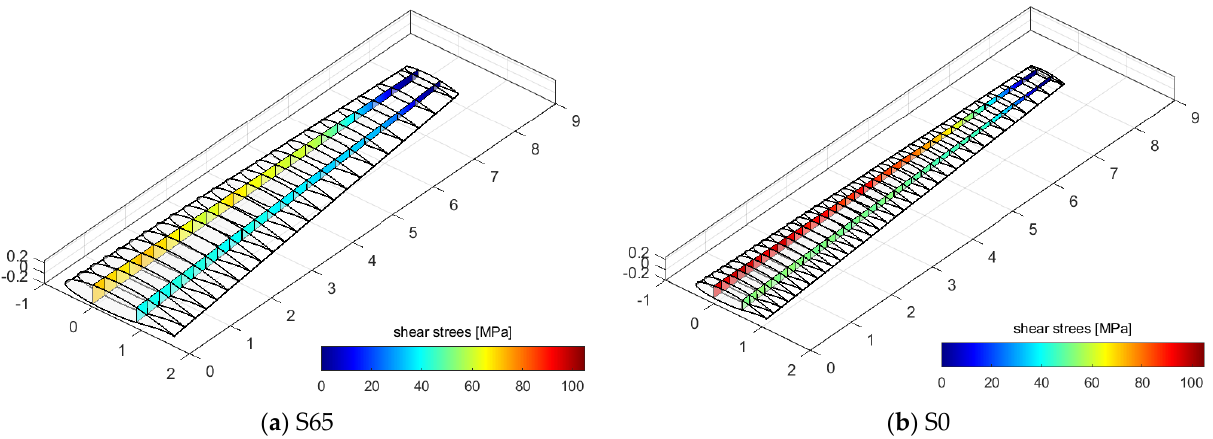
Figure 11. Shear force distribution for the original wing ( a ) and the wing with 65% of original area ( b ).